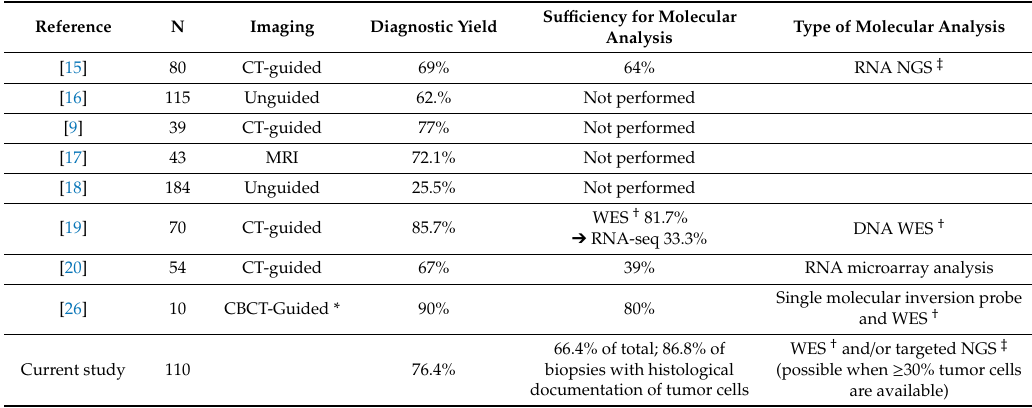
Table 5. Results of previous studies compared to the current